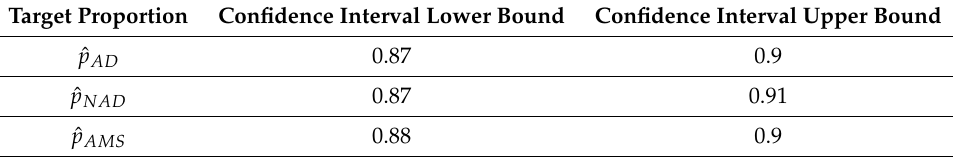
Table 2. The 95% non-parametric confidence